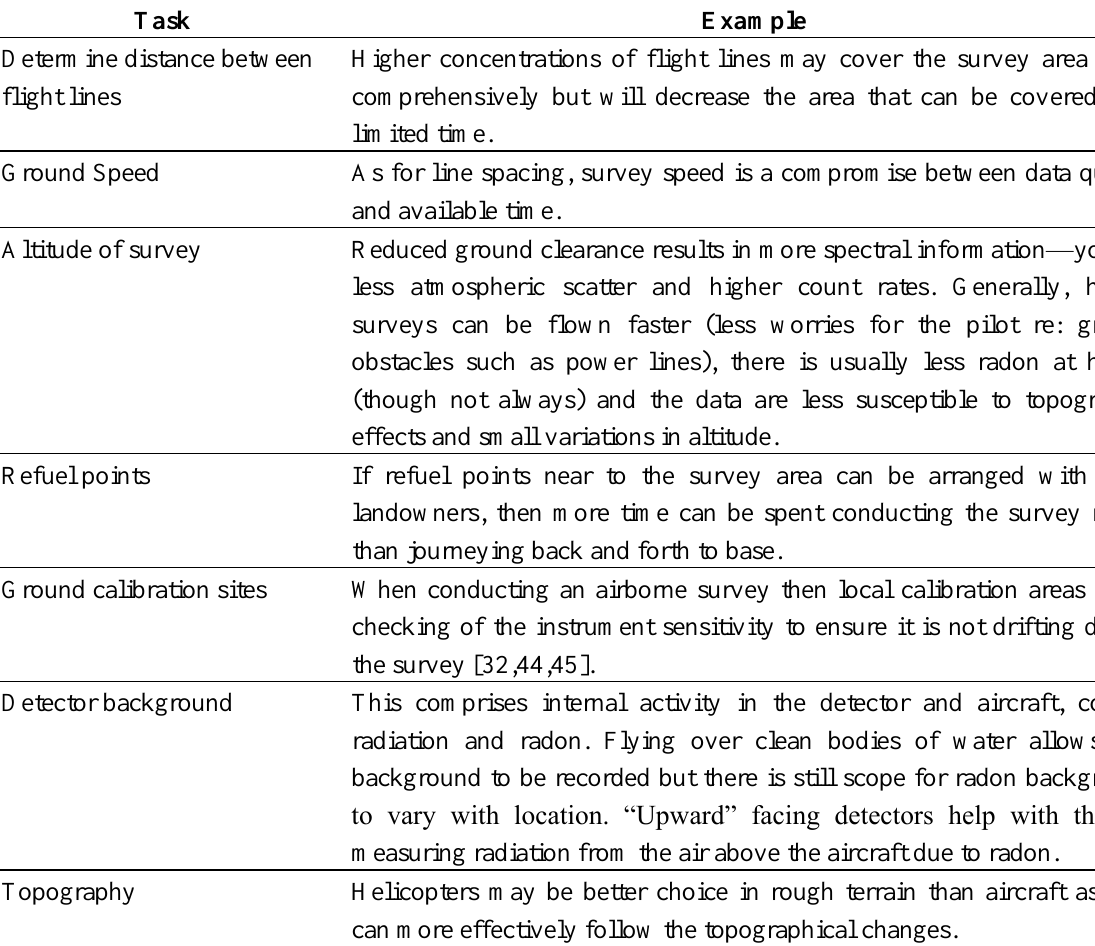
Table 2. Tasks worth considering during an airborne gamma-ray spectrometry